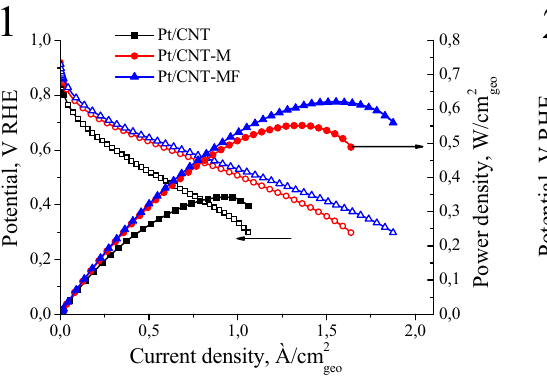
conditions: 82 °C, anode—H 2 (2.4 ml s −1 , 100% RH), cathode— O 2 (4.8 ml s −1 , 70% RH). Pt loading: anode—0.2 mg cm −2 , cath- ode—0.1 mg cm −2 for all the